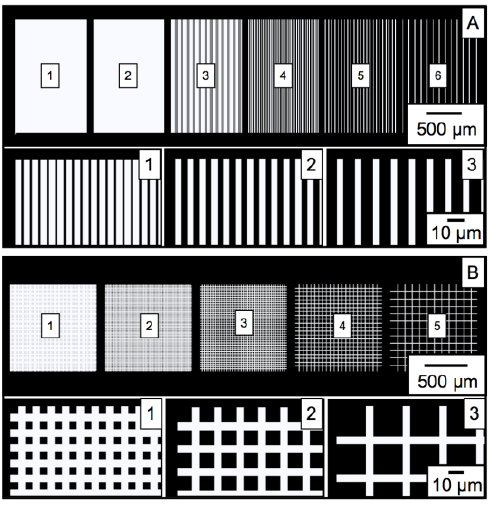
Figure A1. Layout of a line and grid patterns containing PGMA- b -PVDMA patterned films (white) on silicon substrates (black). ( A ) Top Row: Layout of the six line arrays. Line arrays have increased pitch moving from left to right. Bottom Row: Zoomed-in layout of arrays 1, 2, and 3, which contain 5 μ m wide lines with a pitch of 7, 10, and 15 μ m, respectively. ( B ) Top Row: Layout of the five square grid patterns. Grids have increased pitch moving from left to right. Bottom Row: Zoomed-in layout of square grids 1, 2, and 3, which contain 5 μ m wide lines with a pitch of 10,15, and 25 μ m, respectively.